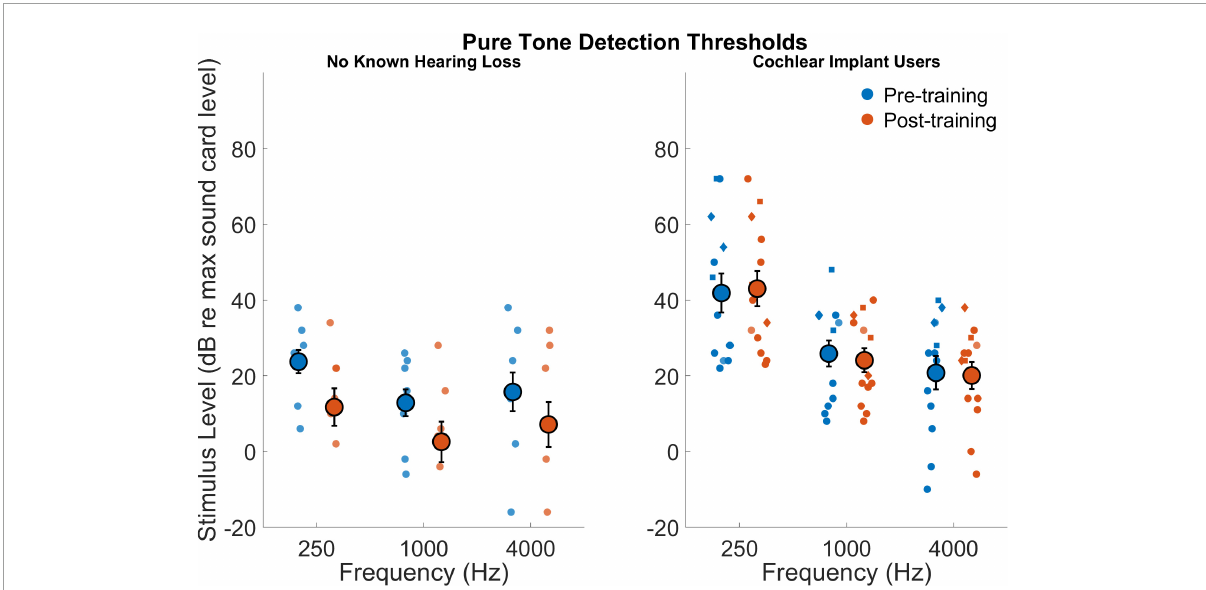
FIGURE2 Stimulus level associated with detection threshold for 250, 1,000, and 4,000 Hz for those with no known hearing loss (left subpanel) and for cochlear implant users (right subpanel). The gain is in decibels with a gain of 100 dB corresponding to the maximum gain of the listening device. Smaller symbols indicate individual thresholds. Individual thresholds for CI users with implants from Cochlear Corporation are represented with a circle, Advanced Bionics with a diamond, and MED-EL with a square. Larger circles indicate group averages for each session with error bars indicating standard errors of the